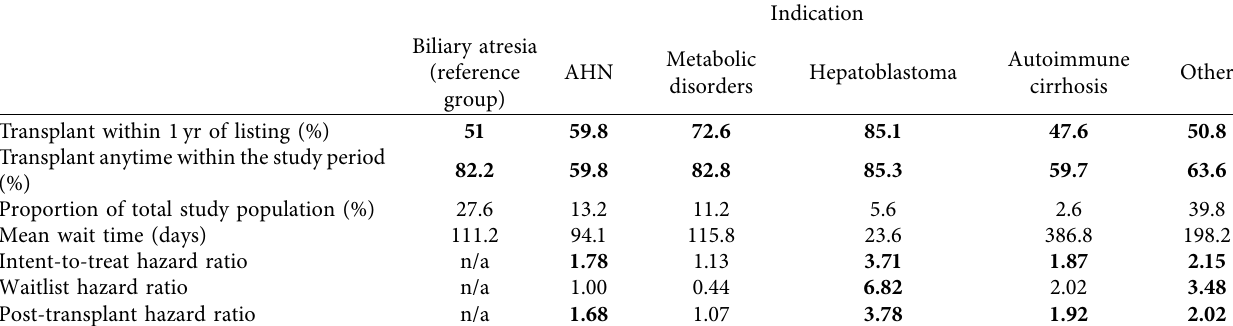
Table 6: Percent of patients who received a transplant, mean wait time to transplant, and intent-to-treat, waitlist, and post-transplant hazard